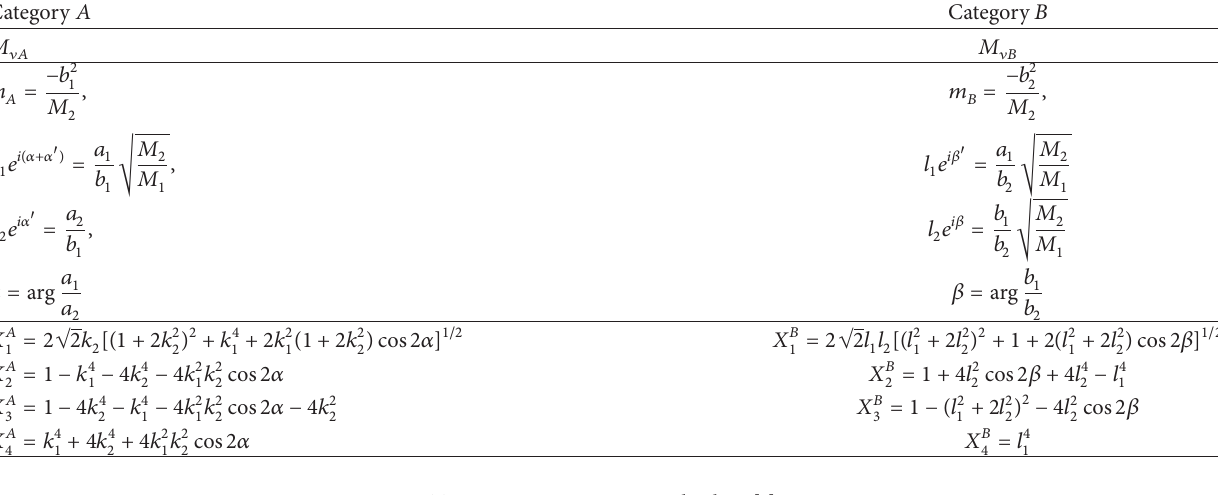
Table 3: Reparametrized quantities and relevant functions in Category 𝐴 and Category 𝐵 .